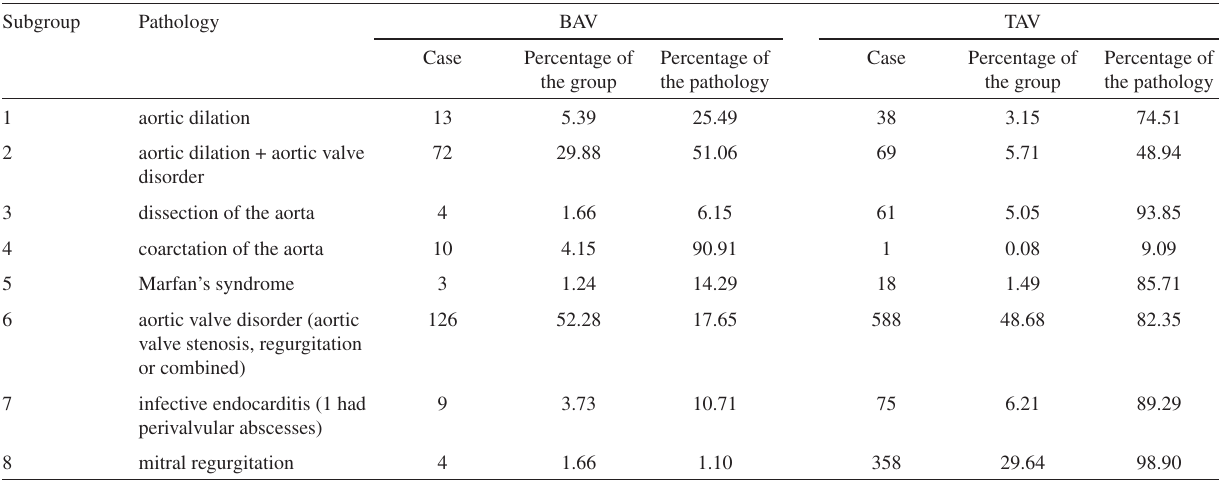
Table 2 - A comparison of the constitutional percentages between BAV and TAV patients of the entire study period. Subgroup